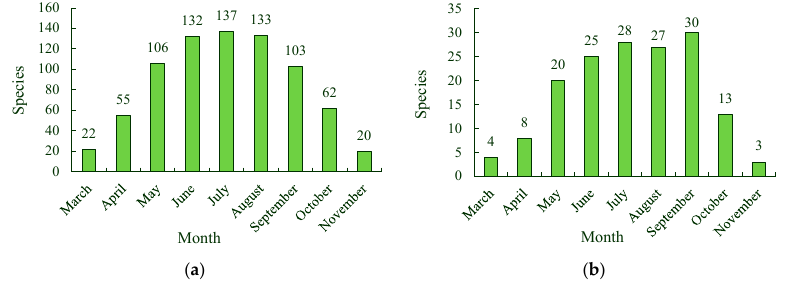
Figure 8. Spontaneous and alien invasive plant species present in their flowering seasons from March to November. ( a ) Species of spontaneous plants in their flowering season. ( b ) Species of alien invasive plants in their flowering season.